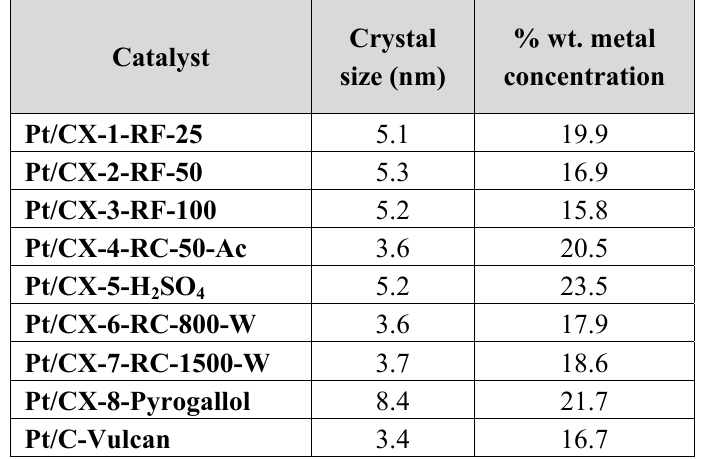
Table 5. Pt crystal size obtained by XRD and Pt concentration in the synthesized